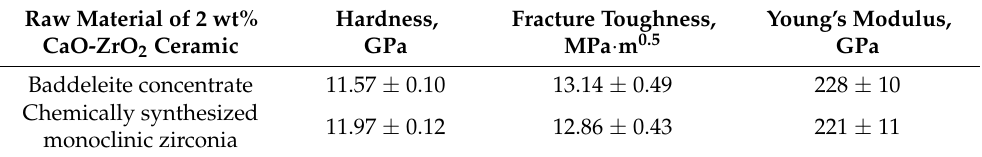
Table 5. Mechanical characteristics of 2-wt% CaO-ZrO 2 ceramics made of the baddeleyite concentrate and chemically synthesized monoclinic zirconia. The sintering temperature is 1300 ◦ C. Raw Material of 2